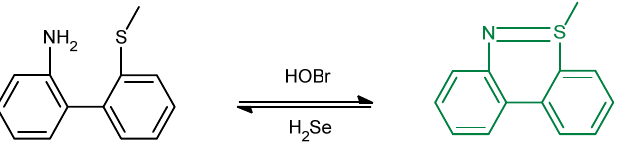
Figure 58. Structure of BPP , a simple sulfilimine model system was described by Luan et al.